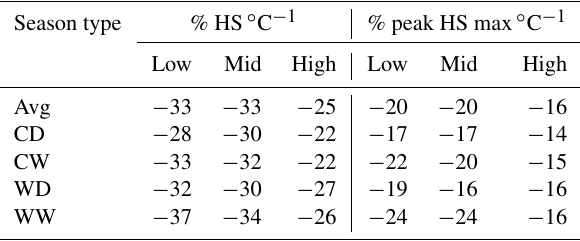
Table 2. Average and seasonal HS and peak HS sensitivity to tem- perature and precipitation change during the four different com- pound temperature and precipitation seasons at three different el-